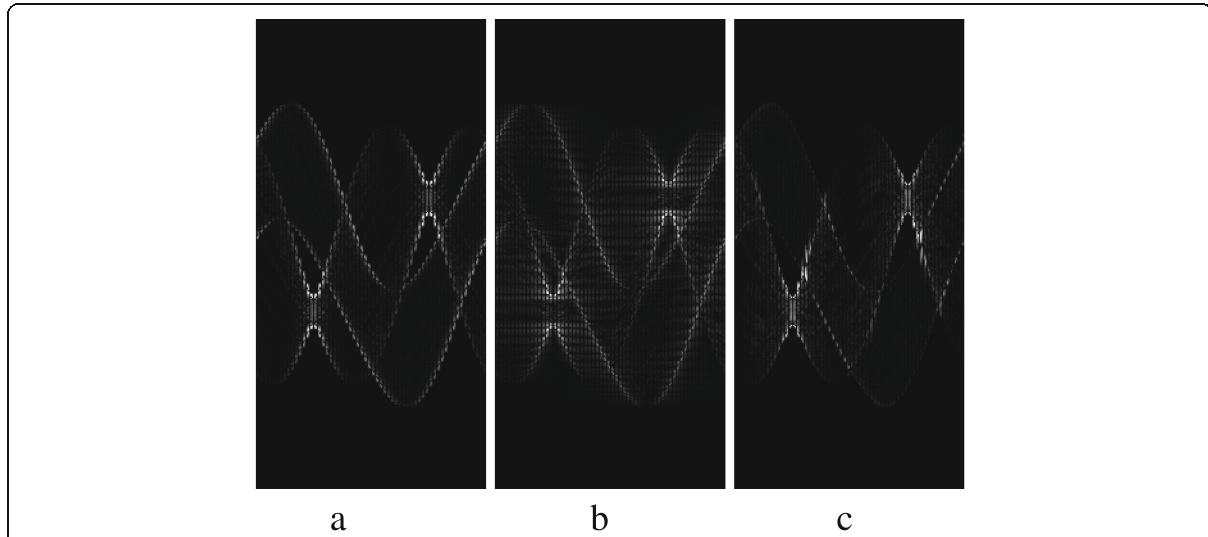
Fig. 3 Absolute error between the estimated sinogram and the true sinogram of 180 views, using a linear interpolation, b sinc function interpolation, and c proposed displacement function interpolation